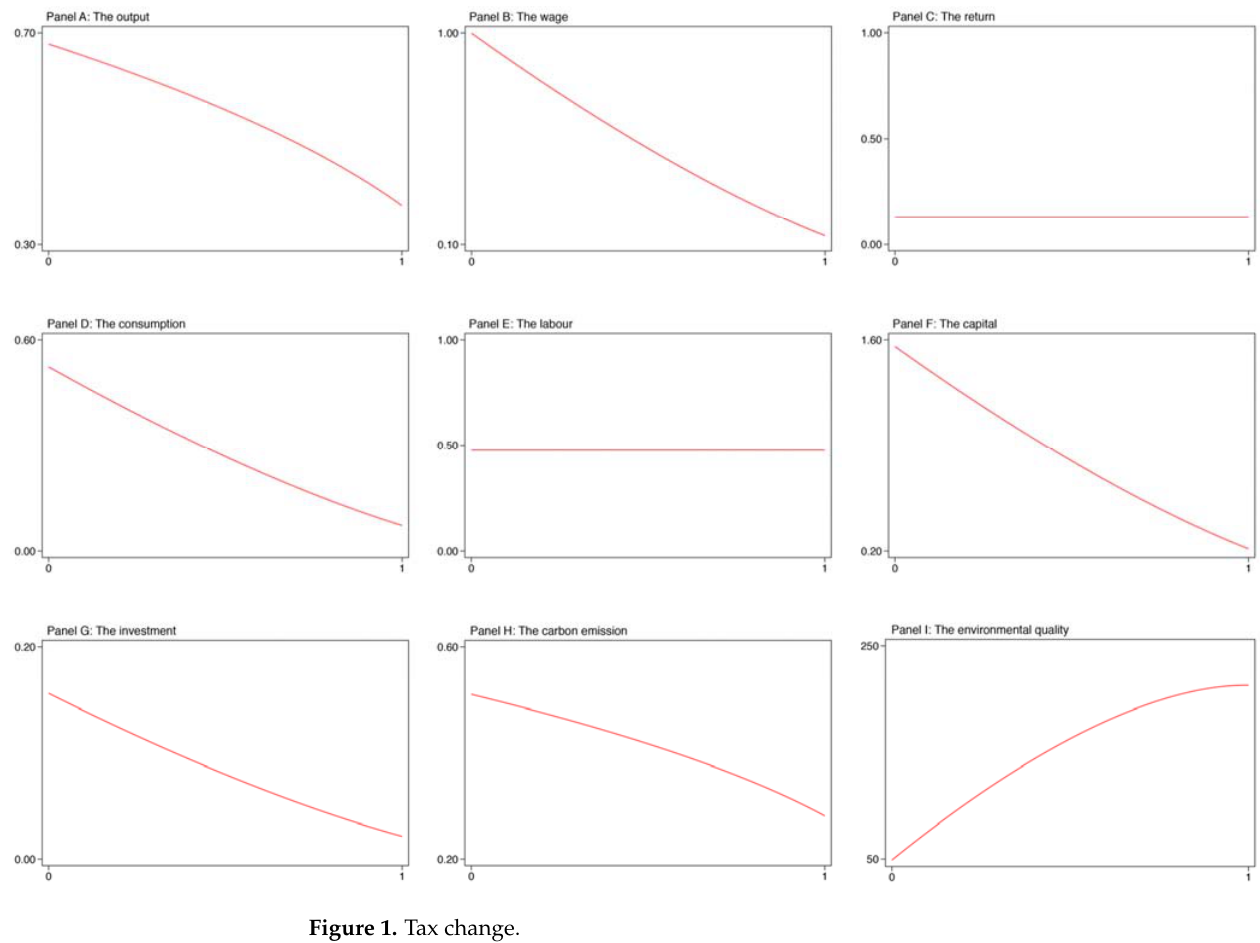
Figure 1. Tax change.